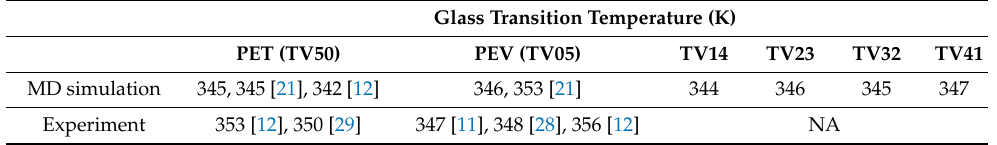
Table 2. Glass transition temperature ( T g ) of PET, PEV, and PET/PEV blends predicted from our MD simulations compared to the previously reported theoretical and experimental data.